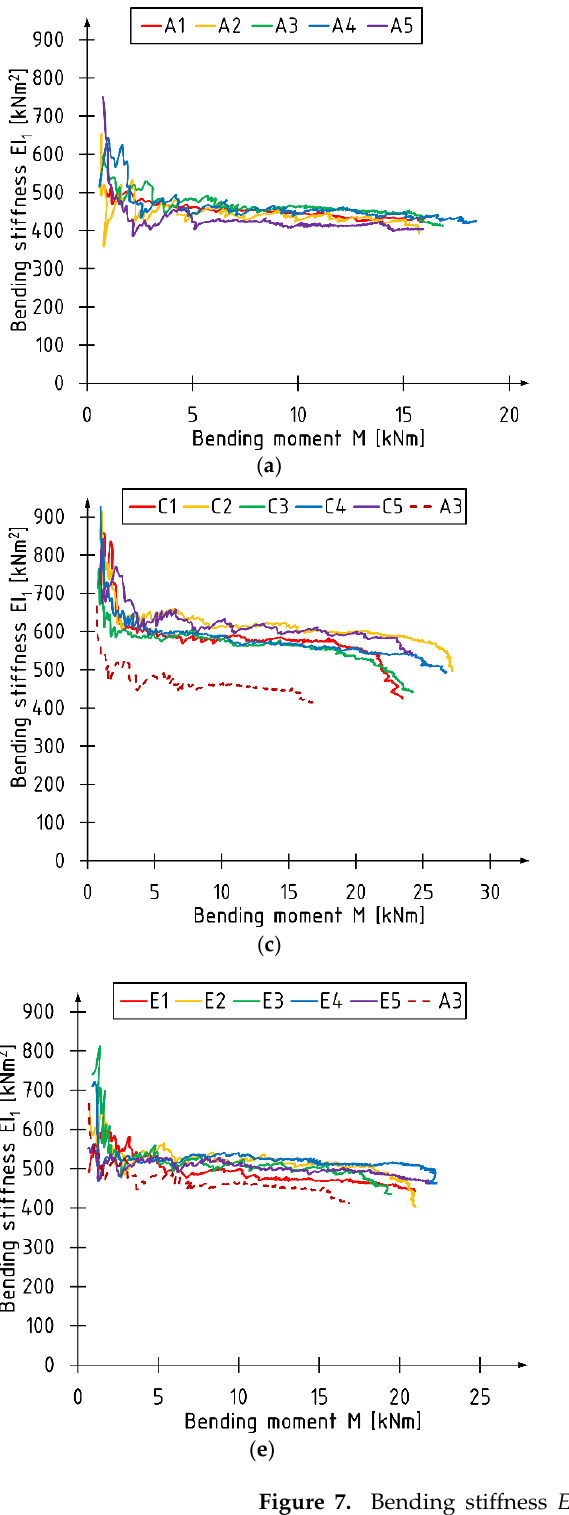
Figure 7. Bending stiffness EI 1 versus bending moment M curves: ( a ) A series; ( b ) B series; ( c ) C series; ( d ) D series; ( e ) E series; ( f ) F series.